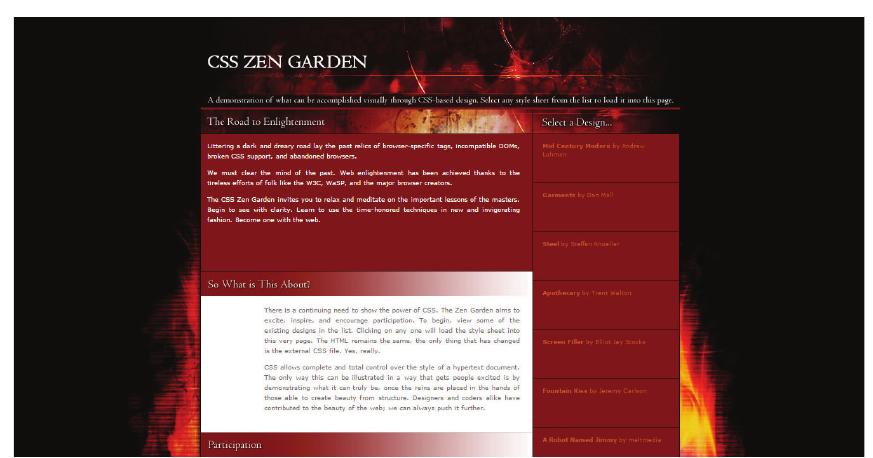
Figure 4: The second user interface used in data